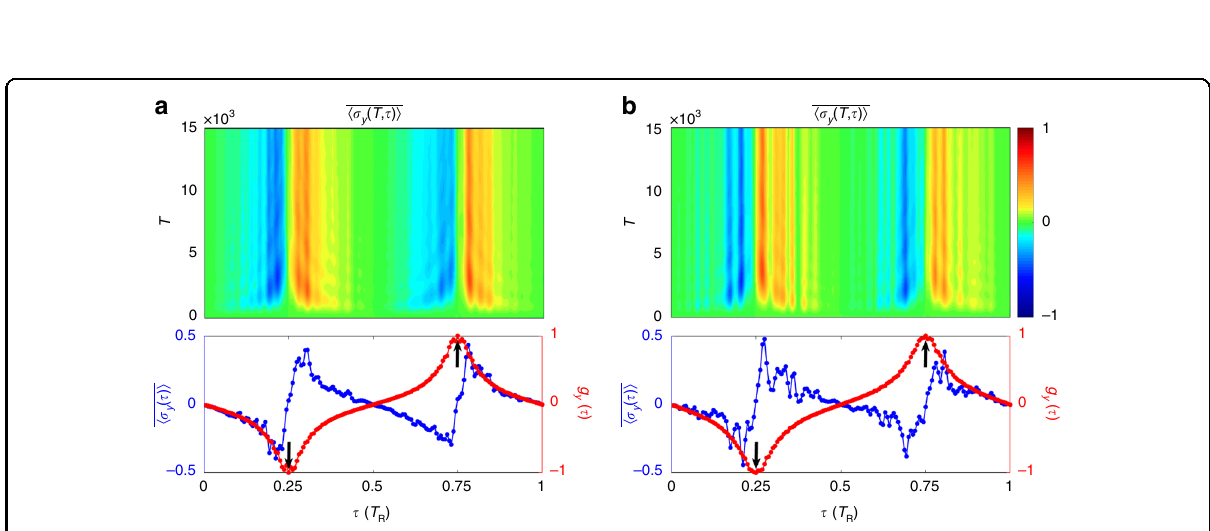
Fig. 5 The time evolution of the normalized spin textures with disorders in the input source. The evolution of averaged spin polarization h σ y ð T ; τ Þi , the overall spin polarization h σ y ð τ Þi , the dynamical spin texture g y ð τ Þ , respectively, with parameters for Fig. 3a, b and disorder in the input source in Eq. (10) with δ ¼ 5 % ( a ) and 10 % ( b ), respectively. Black arrows point to values of g y ð τ 1 ; 2